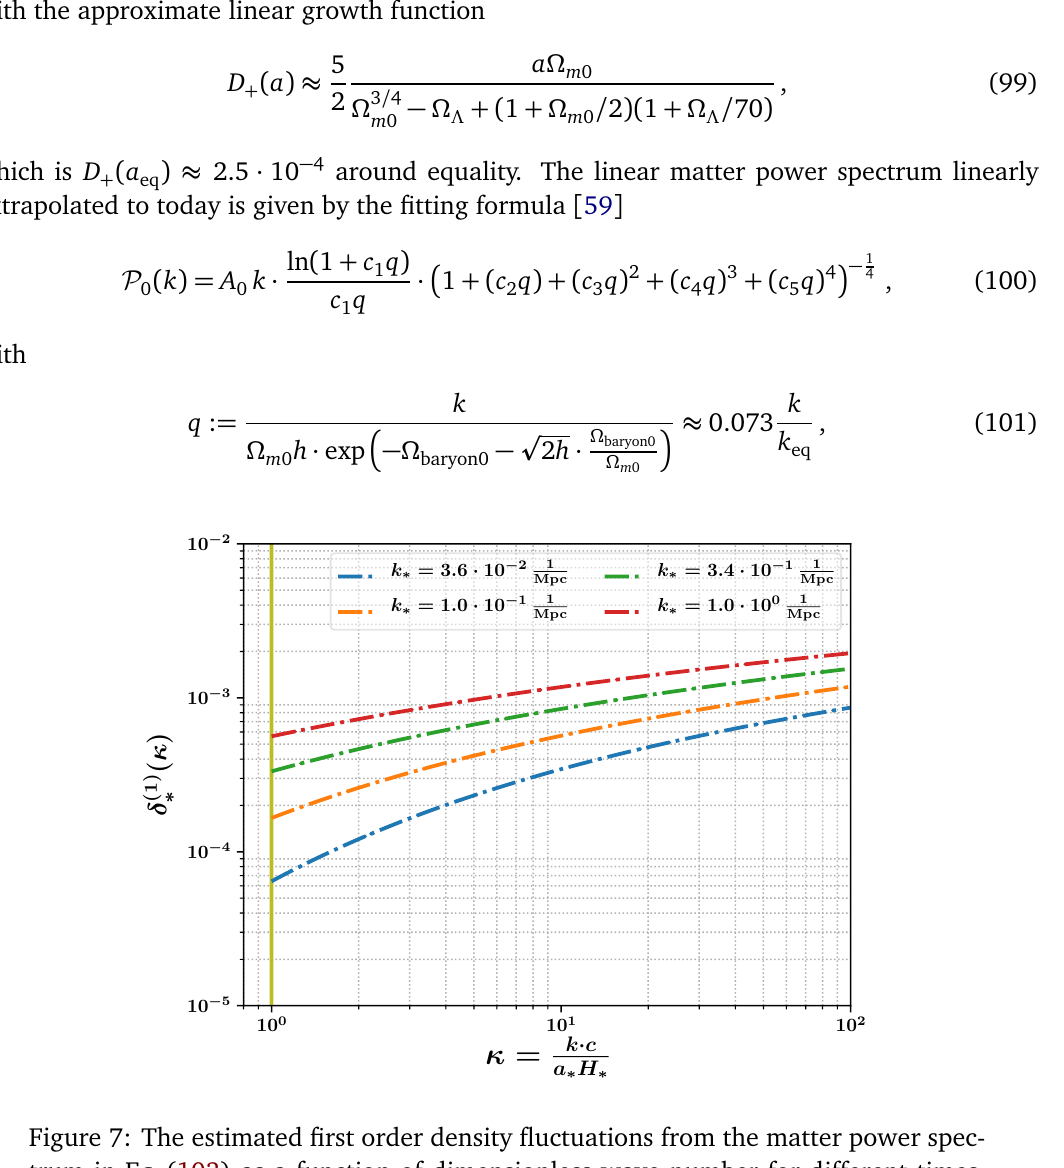
Figure 7: The estimated first order density fluctuations from the matter power spec- trum in Eq. (103) as a function of dimensionless wave number for different times. ∗ H ∗ Here k ∗ = a . The κ -axis and the Hubble horizon shown in yellow are given in c terms of the respective time for each of the